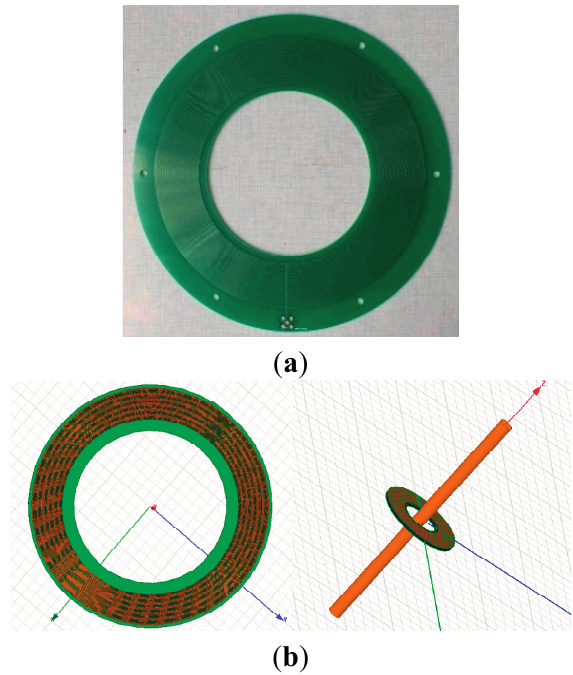
Figure 2. ( a ) Picture of a symmetrical differential D-dot sensor; ( b ) simulation